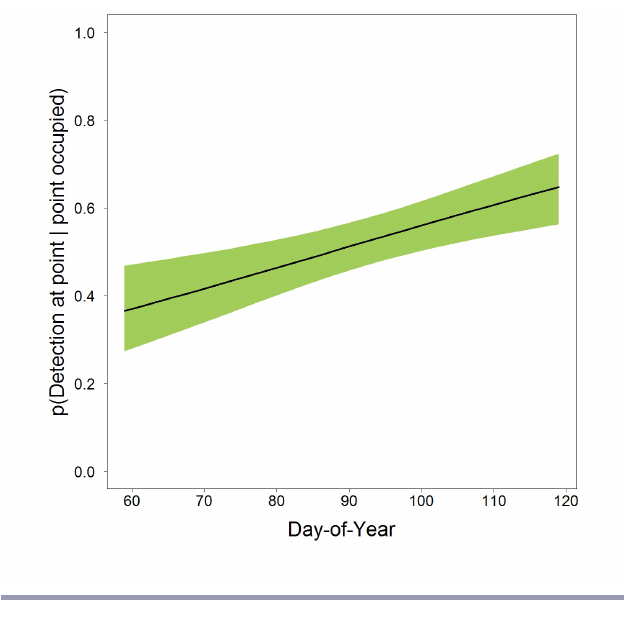
Fig. 3 . Model averaged prediction generated from multiscale occupancy top model set for the effect size of day-of-year on the probability of detecting at least one Short-eared Owl ( Asio flammeus ) at a point given that there is at least one Short-eared Owl at the point during the 2015 breeding season. Black line = model prediction; green area = 95% confidence interval.